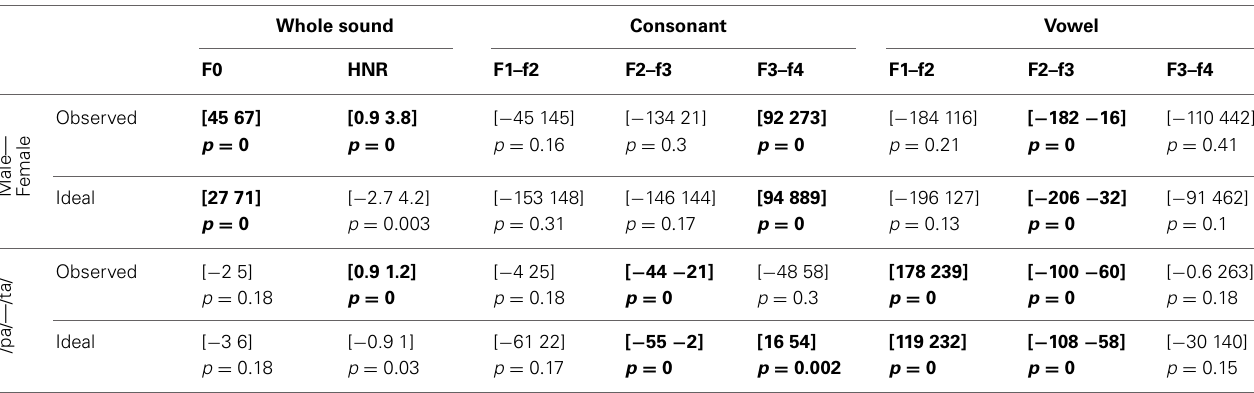
Table 8 | Reverse correlation results for timbre equalized